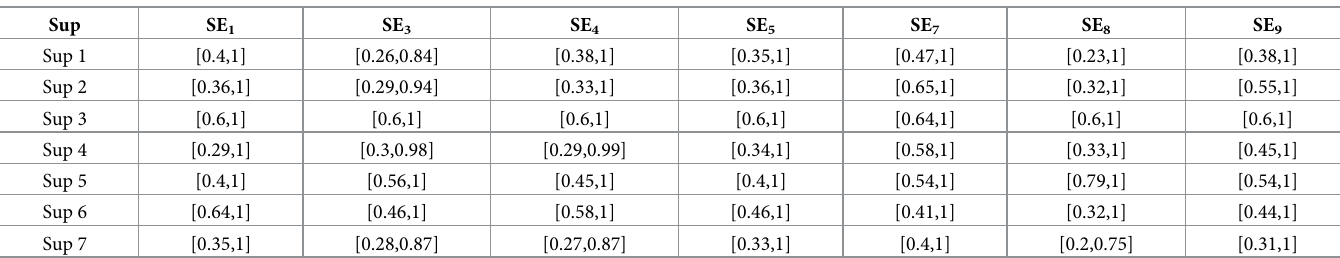
Table 10. Results of sensitivity analysis to indicators for the 7